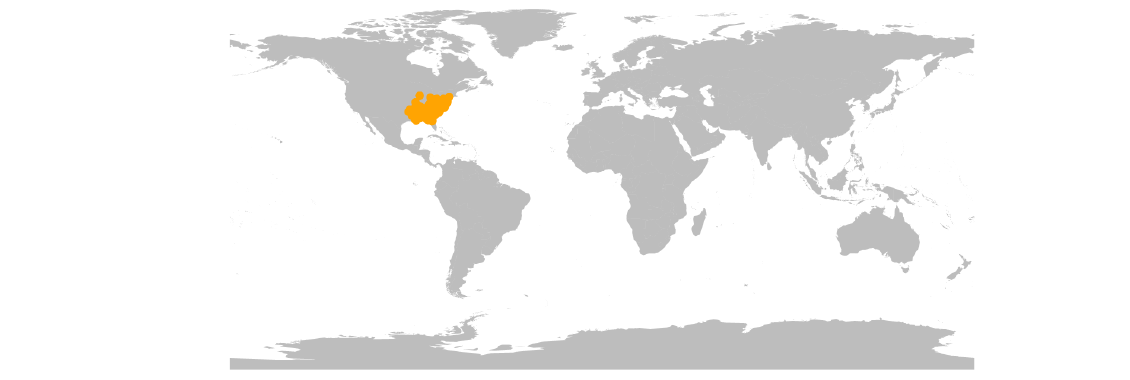
Fig. 47. Distribution of Malus angustifolia (Aiton)